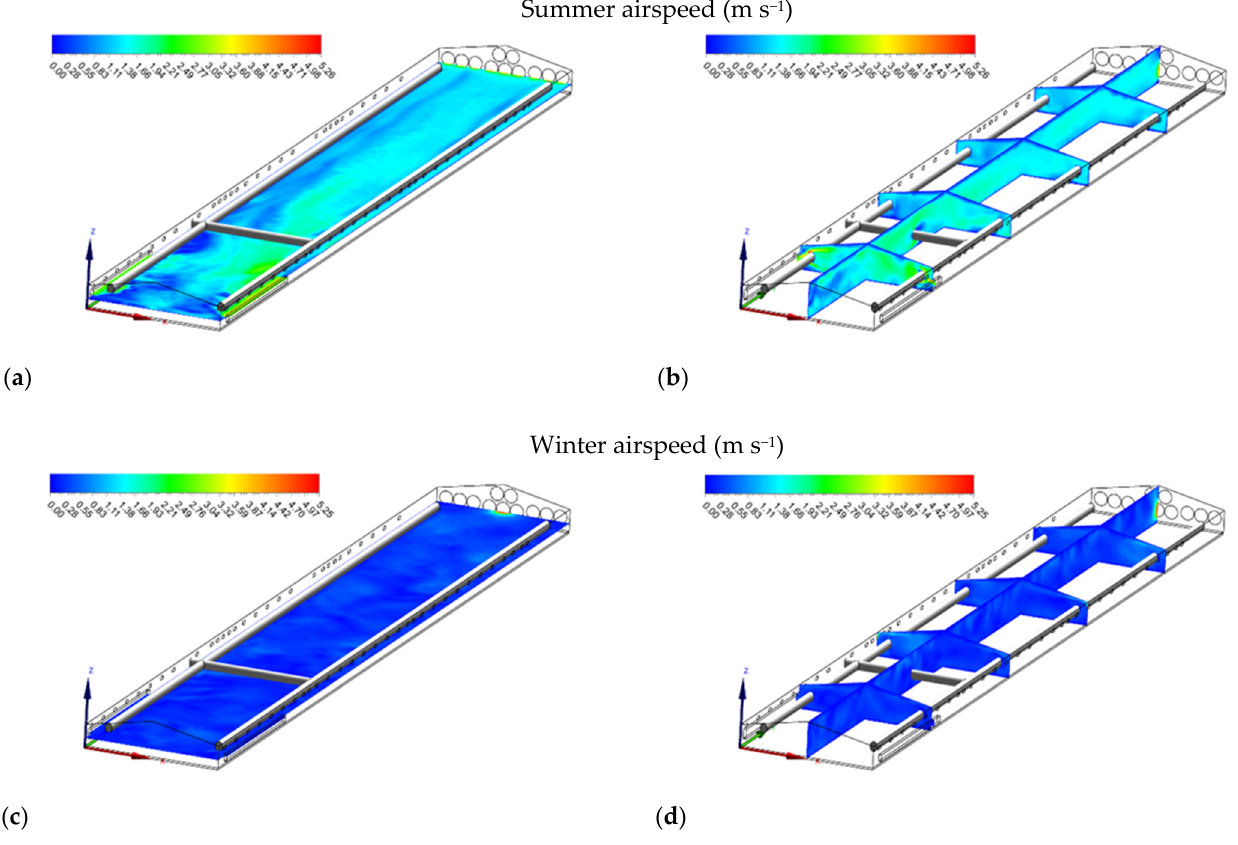
Figure 5. Airspeed (m s − 1 ) contours of slice: z = 1 m, and y 1 = 15 m, y 2 = 35 m, y 3 = 55 m, y 4 = 75 m, and x = 7 m for summer ( a , b ) and winter ( c , d ).